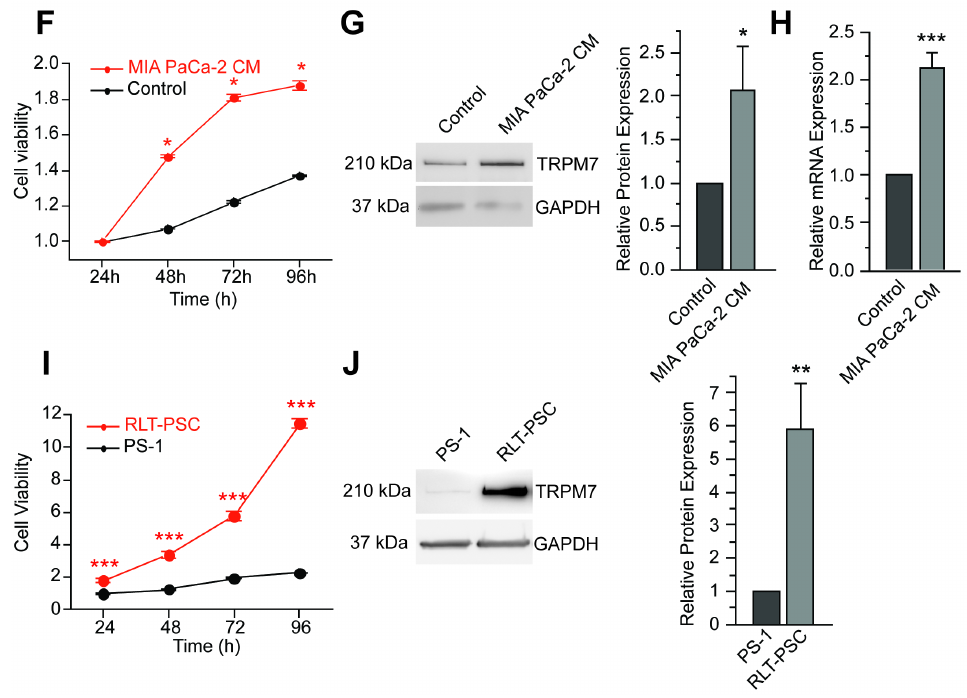
Figure 1. Correlation between TRPM7 expression and PS-1 activation status. ( A ) Lipid droplets were increased after ATRA treatment (as assessed by Nile Red staining). ( B ) Western blot analyses and associated histograms showed a reduced vimentin expression ( n = 3). * indicates p < 0.05 (Mann–Whitney rank sum test). ( C ) Viability of PS-1 stellate cells was decreased upon ATRA treatment ( n = 4). * indicates p < 0.05 (2-ways ANOVA). ( D ) TRPM7 protein expression was decreased in ATRA treated-cells ( n = 3). * indicates p < 0.05 (Mann–Whitney rank sum test). ( E ) mRNA expression levels analyses showed a reduction in TRPM7 transcription following ATRA treatment ( n = 7). *** indicates p < 0.001 (Mann–Whitney rank sum test). ( F ) Viability of PS-1 stellate cells was increased when cells were activated by incubation with Mia PaCa-2 conditioned medium ( n = 3). * indicates p < 0.05 (2-ways ANOVA). ( G ) TRPM7 protein expression was increased when PS-1 cells were cultured in Mia PaCa-2 conditioned medium ( n = 4). * indicates p < 0.05 (Mann–Whitney rank sum test). ( H ) mRNA expression levels analyses revealed an increase in TRPM7 transcription after incubation with Mia PaCa-2 conditioned medium ( n = 3). *** indicates p < 0.001 (Mann–Whitney rank sum test). ( I ) Comparison between PS-1 and RLT-PSC stellate cells showed that RLT-PSC had higher viability than PS-1 cells ( n = 4). *** indicates p < 0.001 (2-ways ANOVA). ( J ) Western blot showing TRPM7 expression in RLT-PSC cells and associated quantification ( n = 6). ** indicates p < 0.01 (Mann–Whitney rank sum